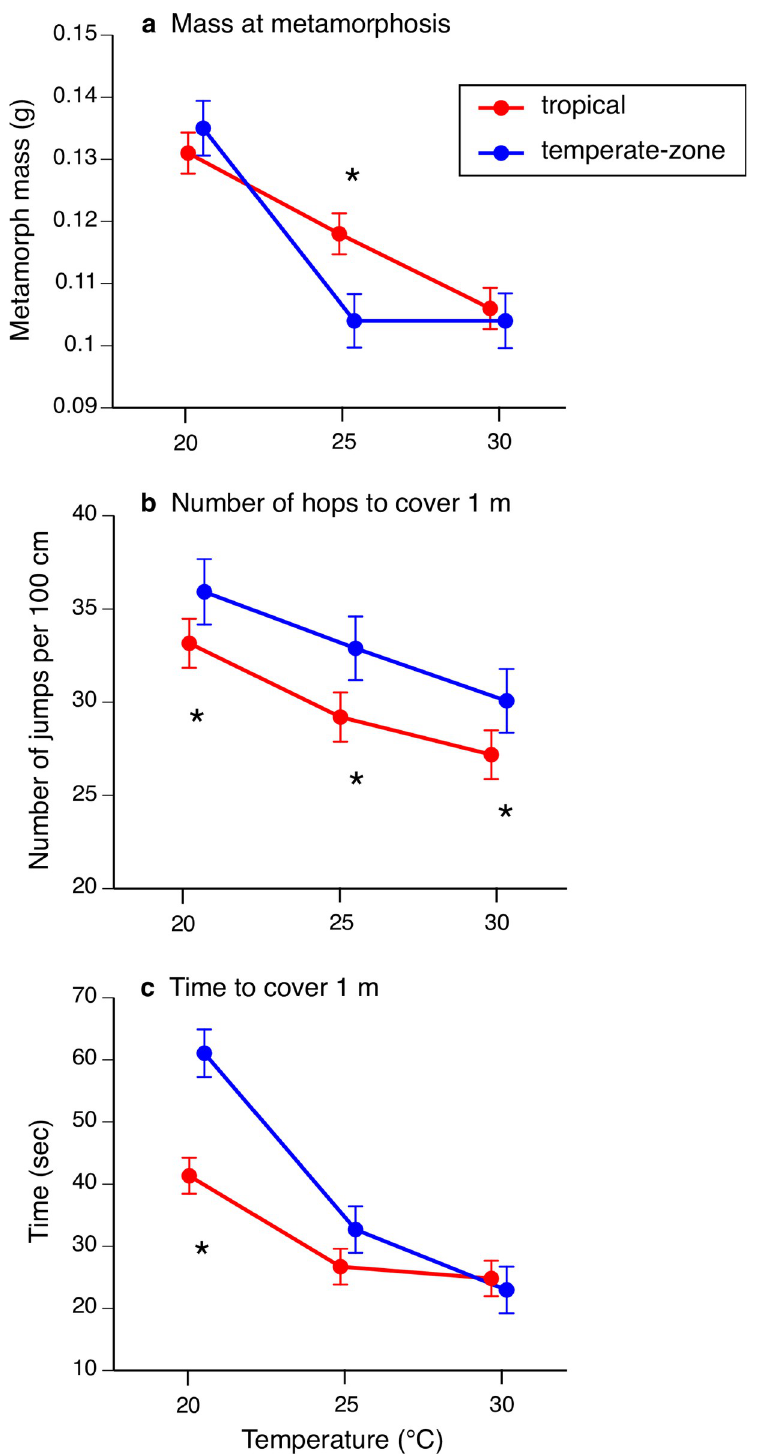
Fig 2. The effects of temperature at which eggs and larvae of cane toads Rhinella marina were raised on body size at metamorphosis, locomotor behaviour, and locomotor speed of metamorphs. Graphs show effect of rearing temperature on ( a ) mass at metamorphosis, ( b ) number of hops required for a metamorph to travel 1 m in laboratory raceway trials, and ( c ) the time taken for a metamorph to travel 1 m in laboratory raceway trials. The panels show data from toads whose parents were collected in two locations: tropical (red) and temperate-zone (blue) Australia. The